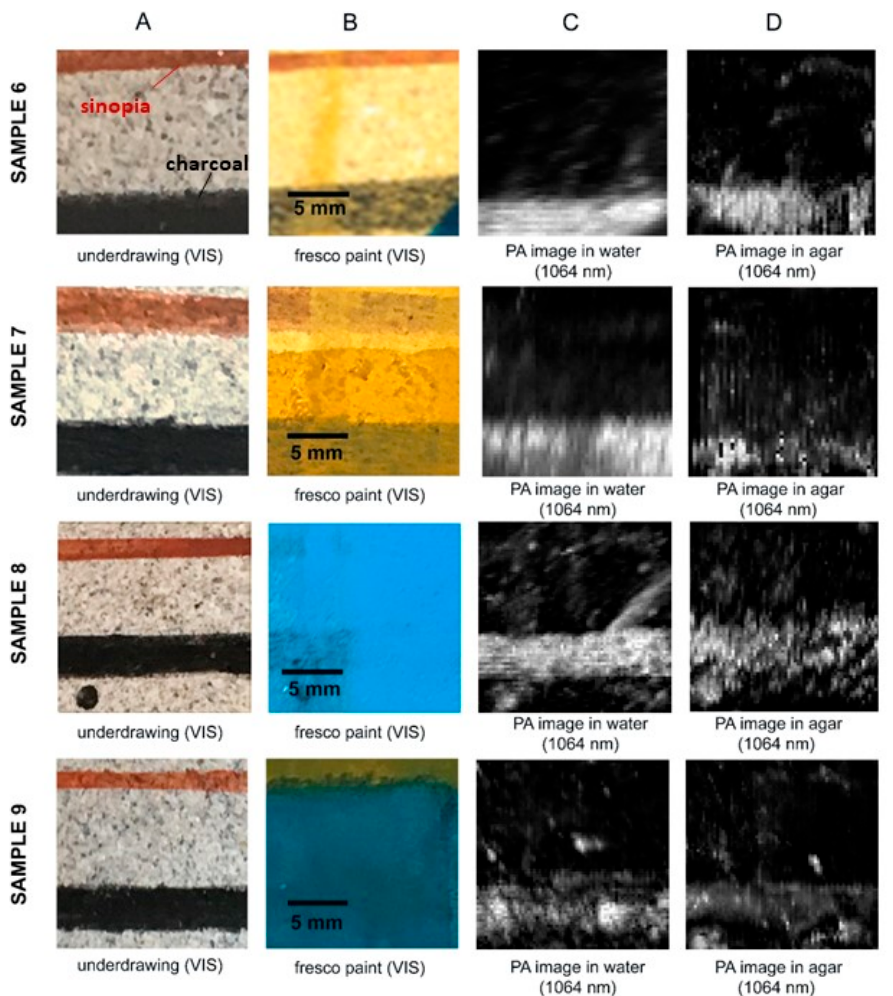
Figure 4. Reflectance PA imaging results on charcoal and sinopia underdrawings ( A ), hidden under pigmented fresco and egg yolk tempera layers. Comparison of experimental results in distilled water ( C ) and in agar gel ( D ). The scale in ( B ) is valid for all images in the row.